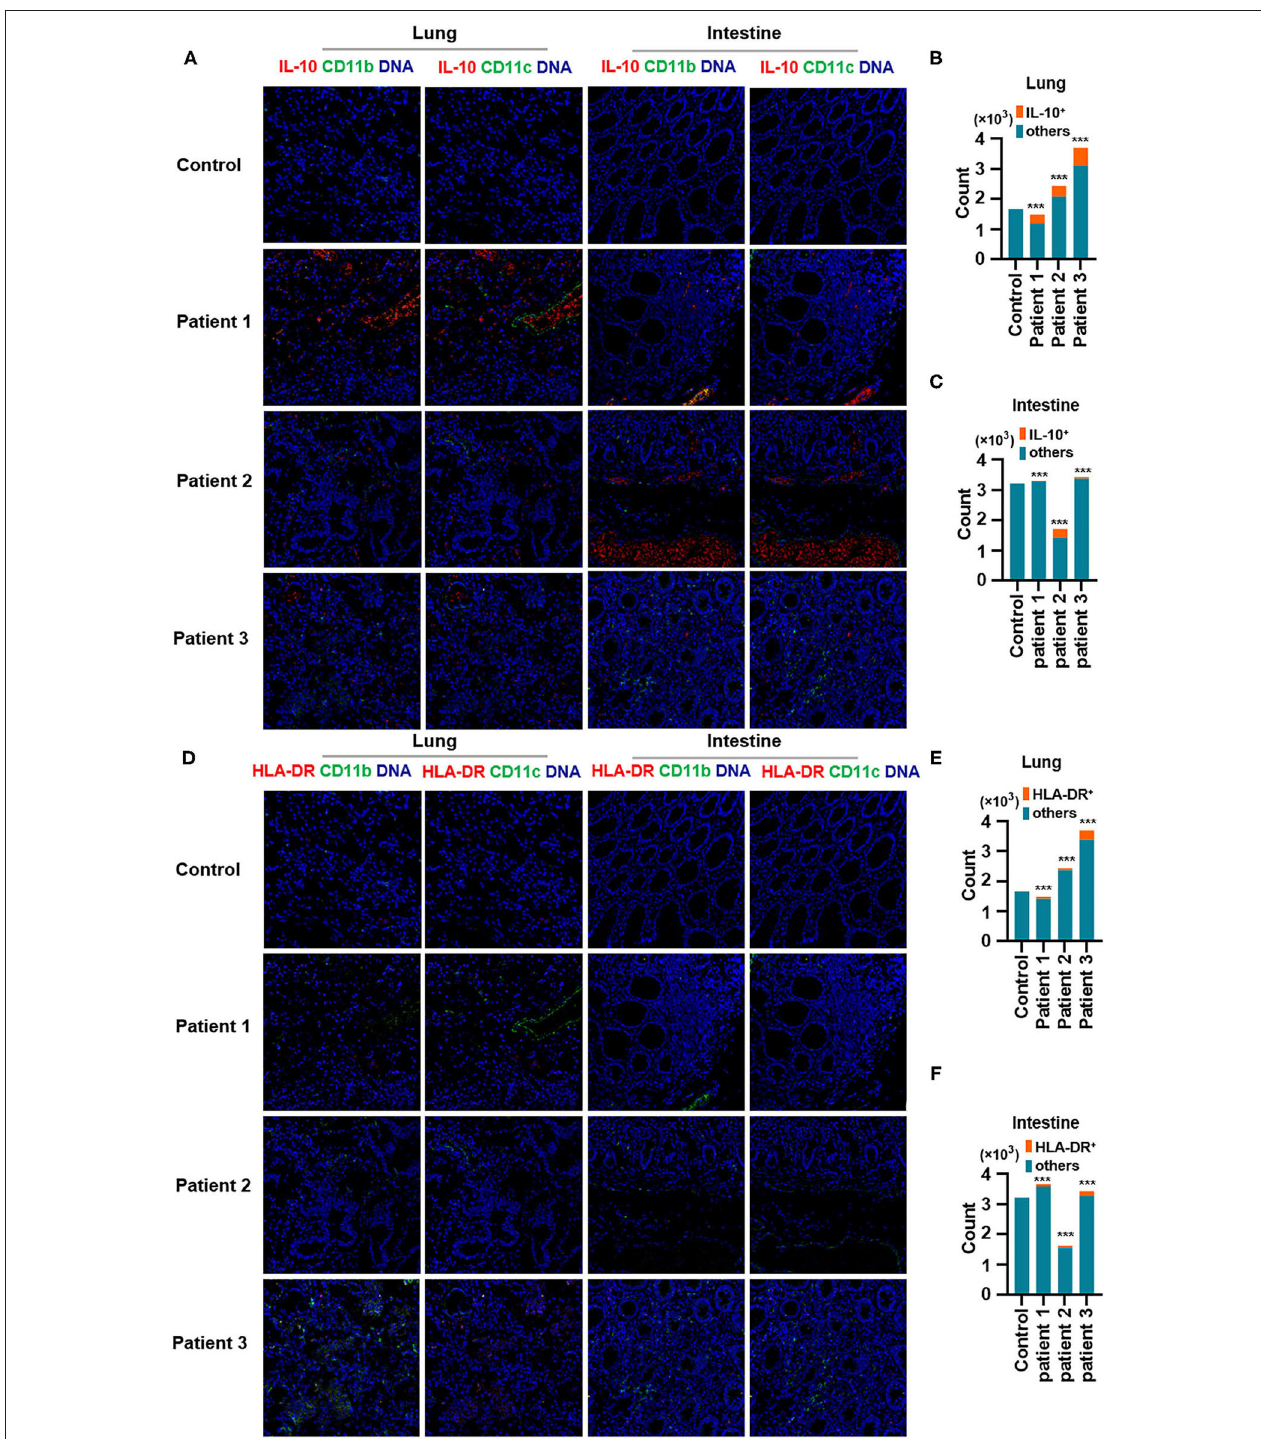
FIGURE 4 | Production of IL-10 and expression of human leukocyte antigen DR isotype (HLA-DR) in the lungs and intestines of patients with coronavirus disease-2019 (COVID-19). (A) Imaging mass cytometry (IMC) for IL-10, CD11b, and CD11c in the lungs and intestine of controls and patients with COVID-19. Iridium-DNA staining is shown in blue, IL-10 staining is shown in red, and CD11b and CD11c staining is shown in green. (B,C) Bar plot for the comparison of IL-10, CD11b, and CD11c in the lungs and intestine of controls and three patients with COVID-19. (D) IMC for HLA-DR, CD11b, and CD11c in the lungs and intestine of controls and patients with COVID-19. Iridium-DNA staining is shown in blue, HLA-DR staining is shown in red, and CD11b and CD11c staining is shown in green. (E,F) Bar plot for the comparison of HLA-DR in the lungs and intestine of controls and patients with COVID-19. The significance of differences between groups is shown as horizontal brackets and was assessed using Fisher’s exact test. *** P < 0.01; ns, P > 0.01.